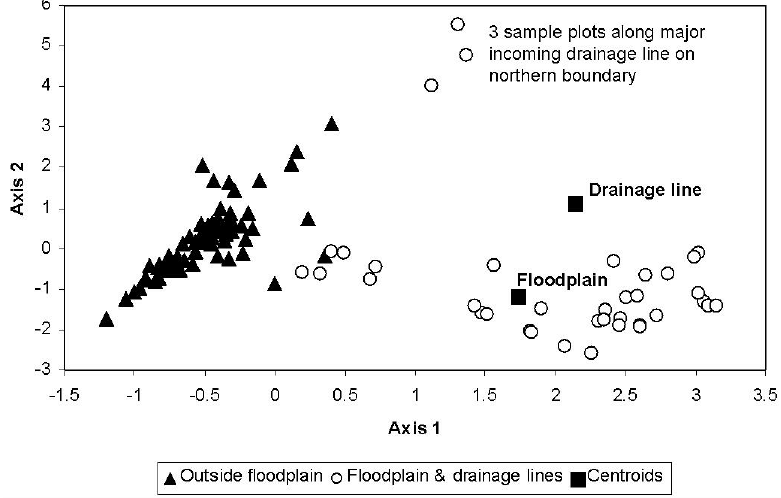
Fig. 4. C ANOCO ordination of 115 vegetation sample plots in the Parque Nacional de Ban- hine. Note dense cloud of sample plots on left side of diagram with outlying plots to the right that represent vegetation in areas with high moisture